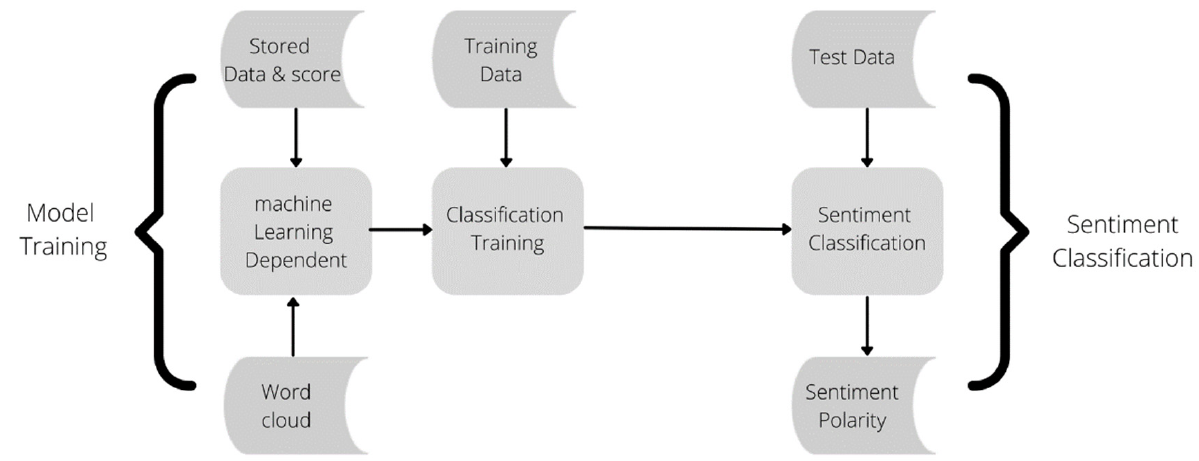
Figure 10. Machine learning workflow.